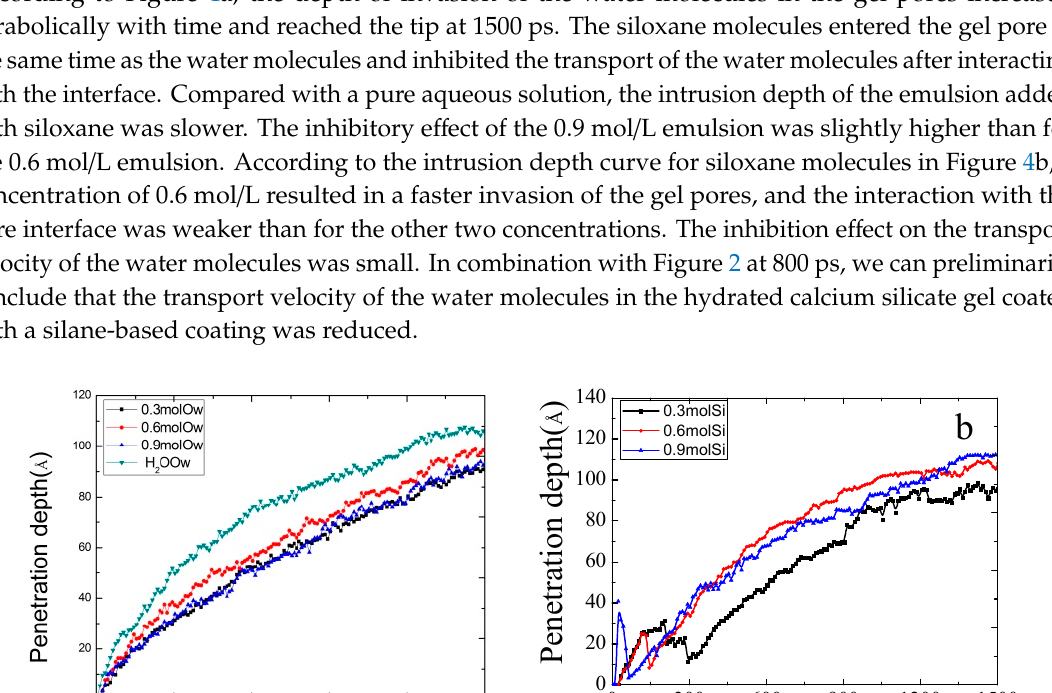
Figure 4. Penetration depth of ( a ) four different models of water molecules, and ( b ) three different models of siloxane molecules.